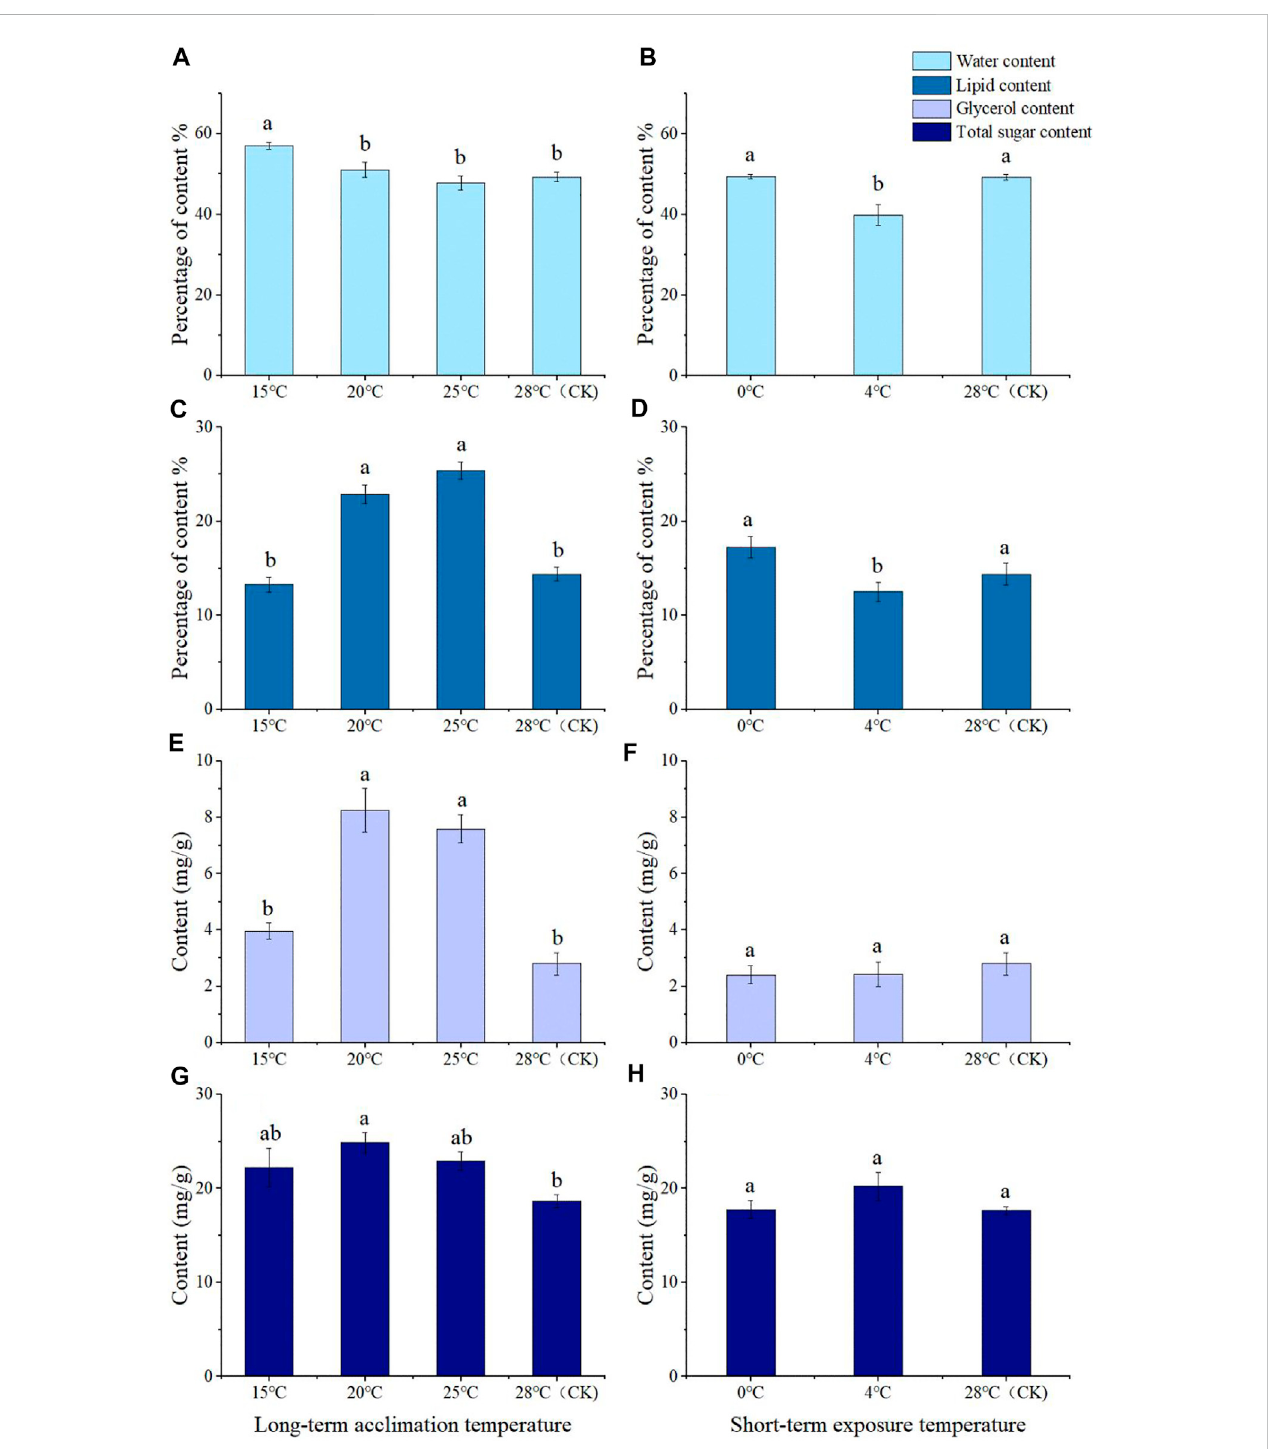
among temperature treatments under the same physiological indexes (Kruskal – Wallis test, One-Way ANOVA, Tukey, p <